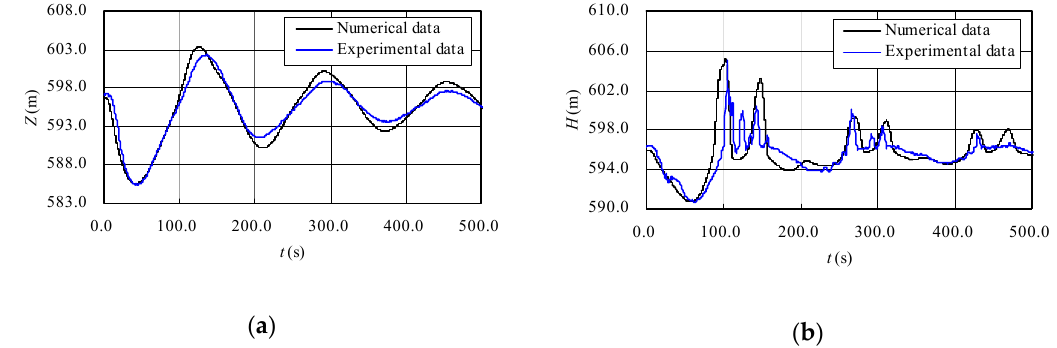
Figure 9. Time histories of the water level in the surge tank and piezometric head in section A under C1: ( a ) water level in surge tank; ( b ) piezometric head at section A.